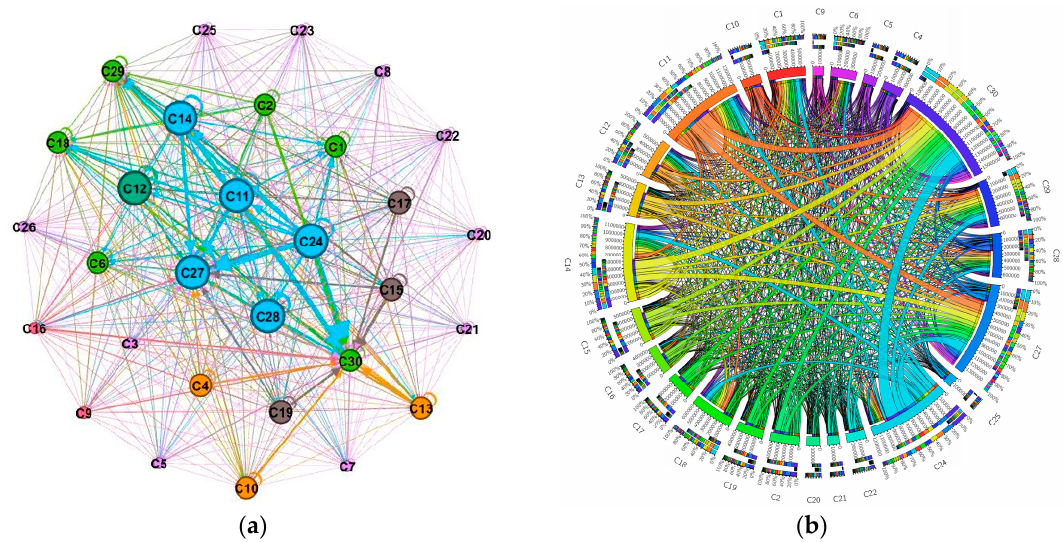
Figure 6. Graph of Embodied carbon emissions flows between industry sectors in Liaoning. ( a ) Embodied carbon emissions network; ( b ) Embodied carbon emissions